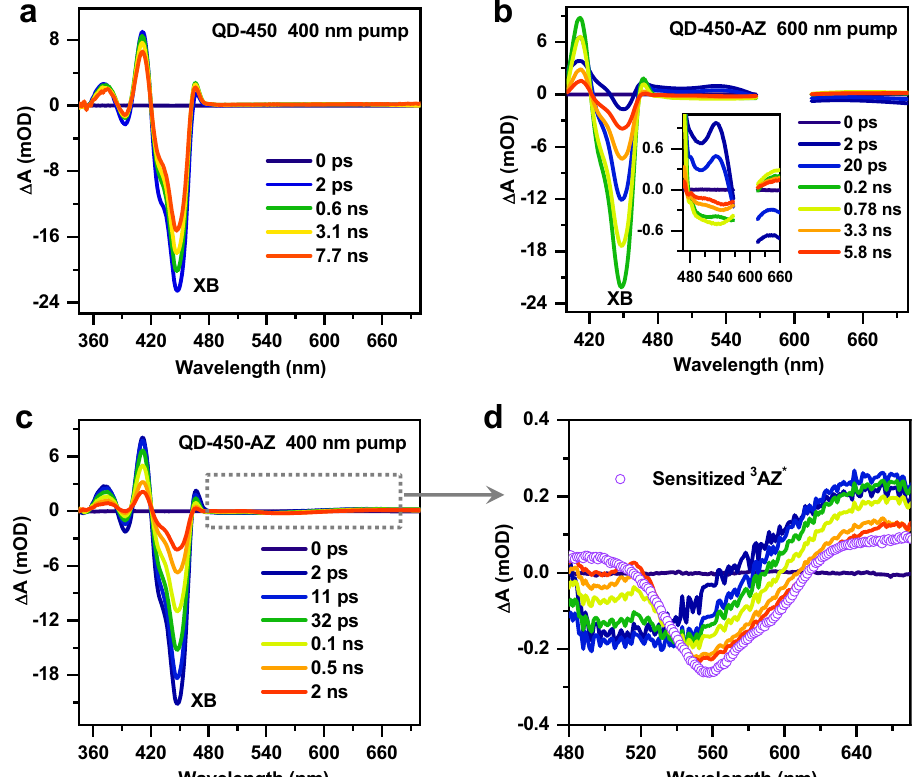
Fig. 3 TA spectra in QD – AZ complexes. a TA spectra of free CdS QD-450nm following 400 nm excitation. b, c TA spectra of QD-450-AZ complexes following b 600 nm and c 400nm excitations. Inset in b shows the enlarged view of AZ signals. d Enlarged view of AZ signals in c . The 3 AZ* spectrum obtained by triplet sensitization (purple circles) is also shown for